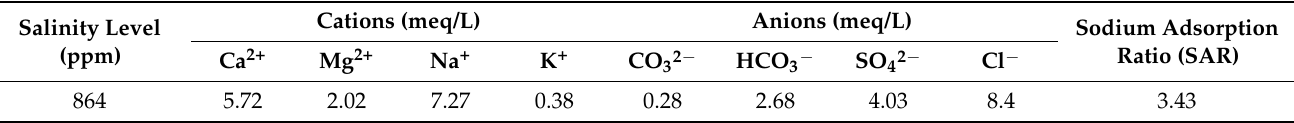
Table 3. Chemical properties and compositions of the irrigation